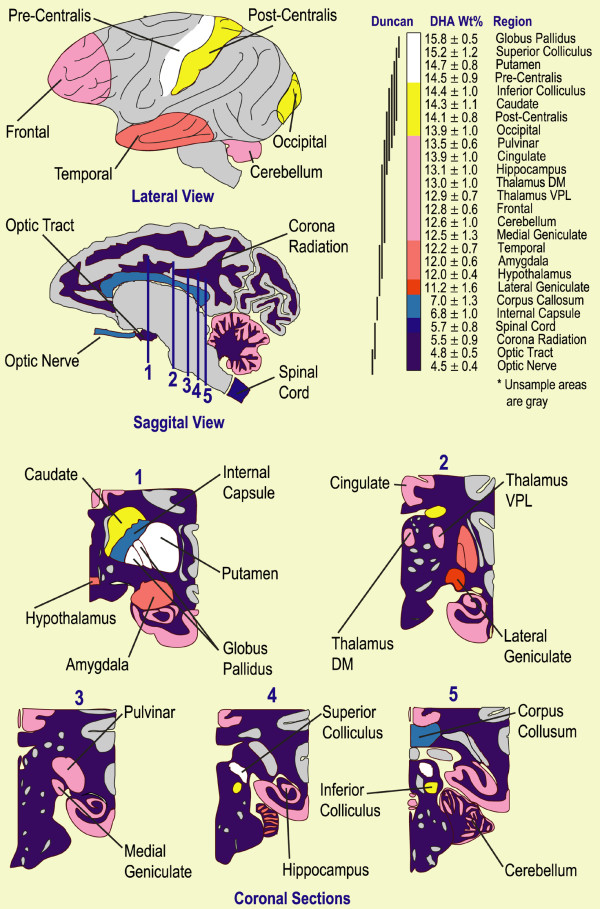
Baboon Neonate CNS DHA Map. Schematic diagram of four-week old baboon central nervous system with DHA concentrations color coded and ranked highest (white) to lowest (dark blue). Numbered lines in the parasagittal section refer to coronal sections; in this view, right side is shown with most of the right hemisphere removed for clarity. "Duncan" refers to Duncan's multiple range test; means sharing a line are not statistically different (p < 0.05). The colors each span 10% of the DHA concentration range.